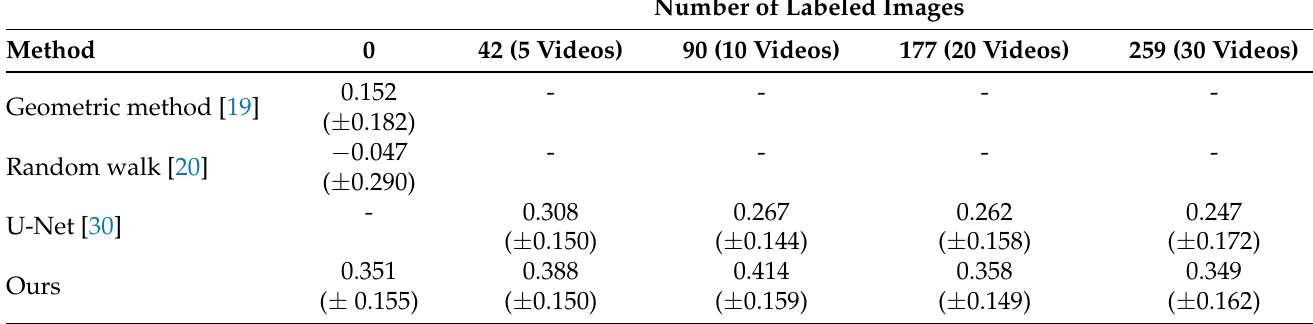
Table 2. Evaluation of the estimation of shadow intensities. Scores are the correlation coefficient calculated by Equation (15). The coefficients are calculated for each testing image, and means over them are shown. The numbers in parentheses are the standard deviations.